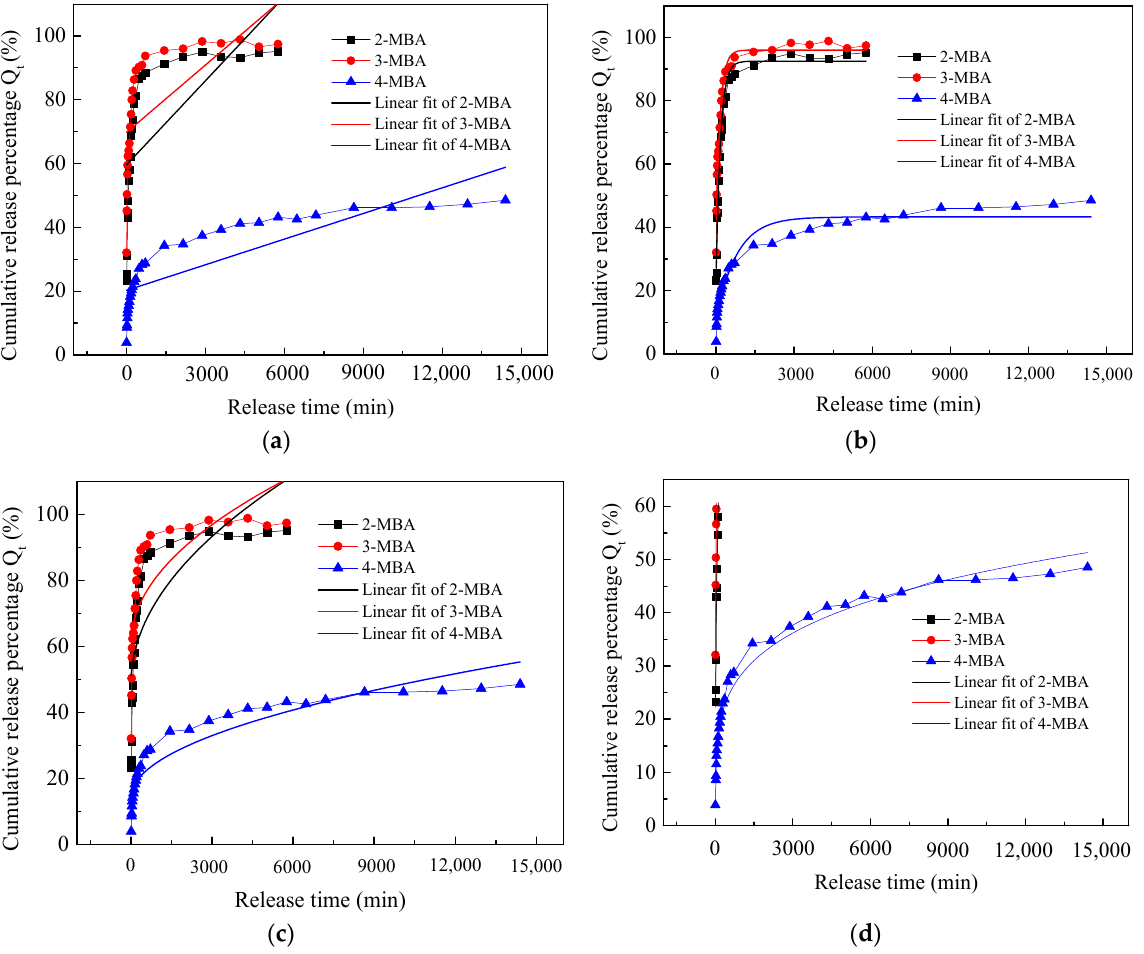
Figure 4. The release kinetics model fi tt ing curves of 2-MBA, 3-MBA, and 4-MBA drugs: ( a ) zero-order release kinetics; ( b ) fi rst-order kinetics model; ( c ) Higuchi model; and ( d ) Korsmeyer–Peppas model. Table 3. The release kinetics model fi tt ing parameters of 2-MBA, 3-MBA, and 4-MBA drugs. Drugs